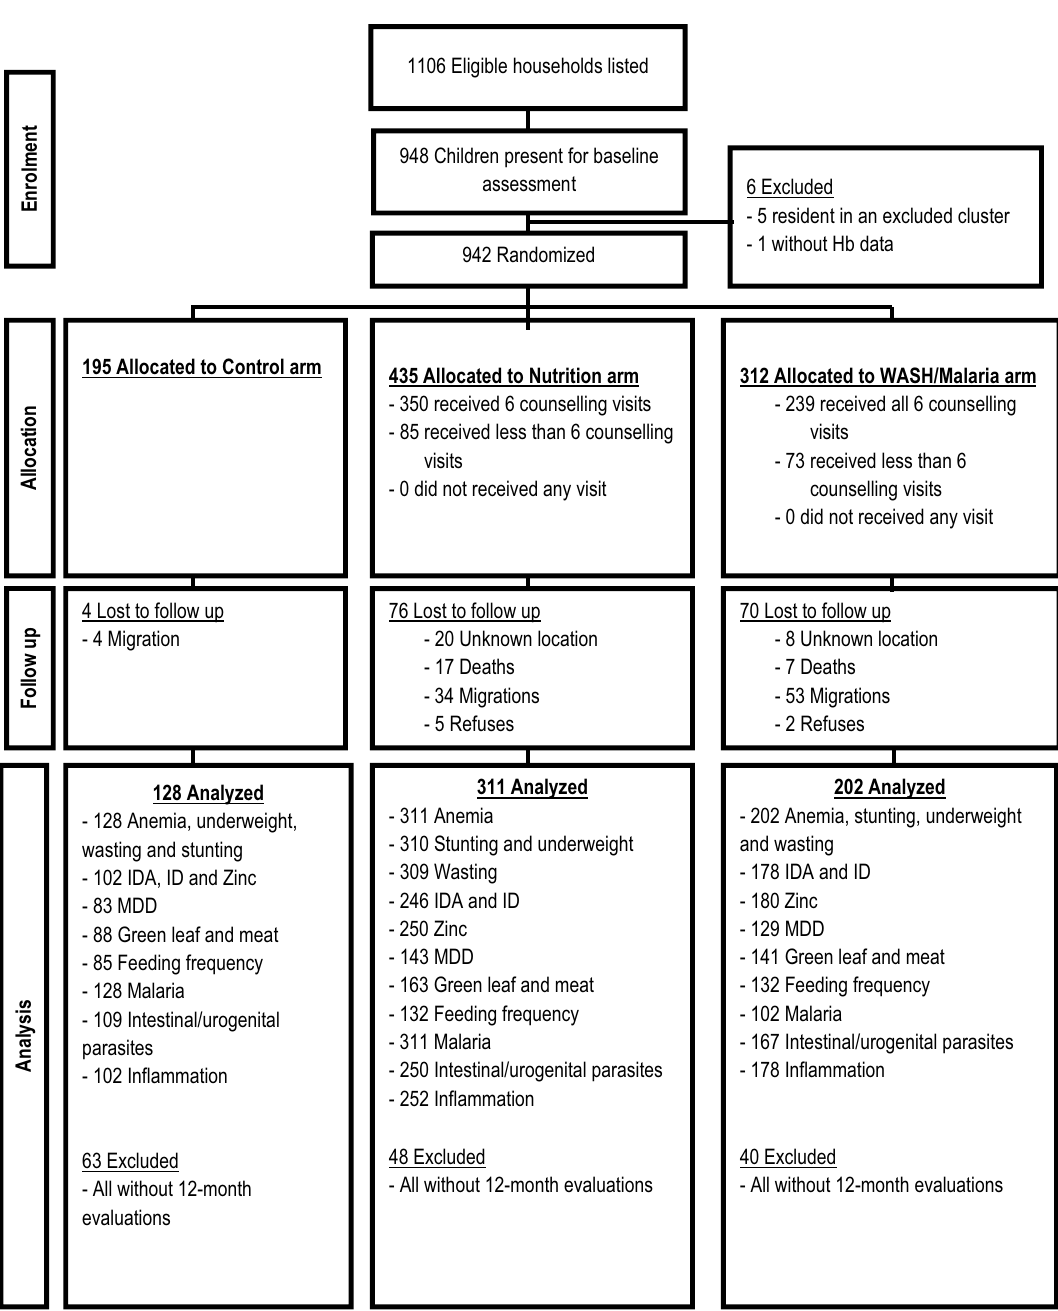
Figure 1. Children follow up flowchart. Hb hemoglobin, IDA iron deficiency anemia, ID iron deficiency, MDD minimum dietary